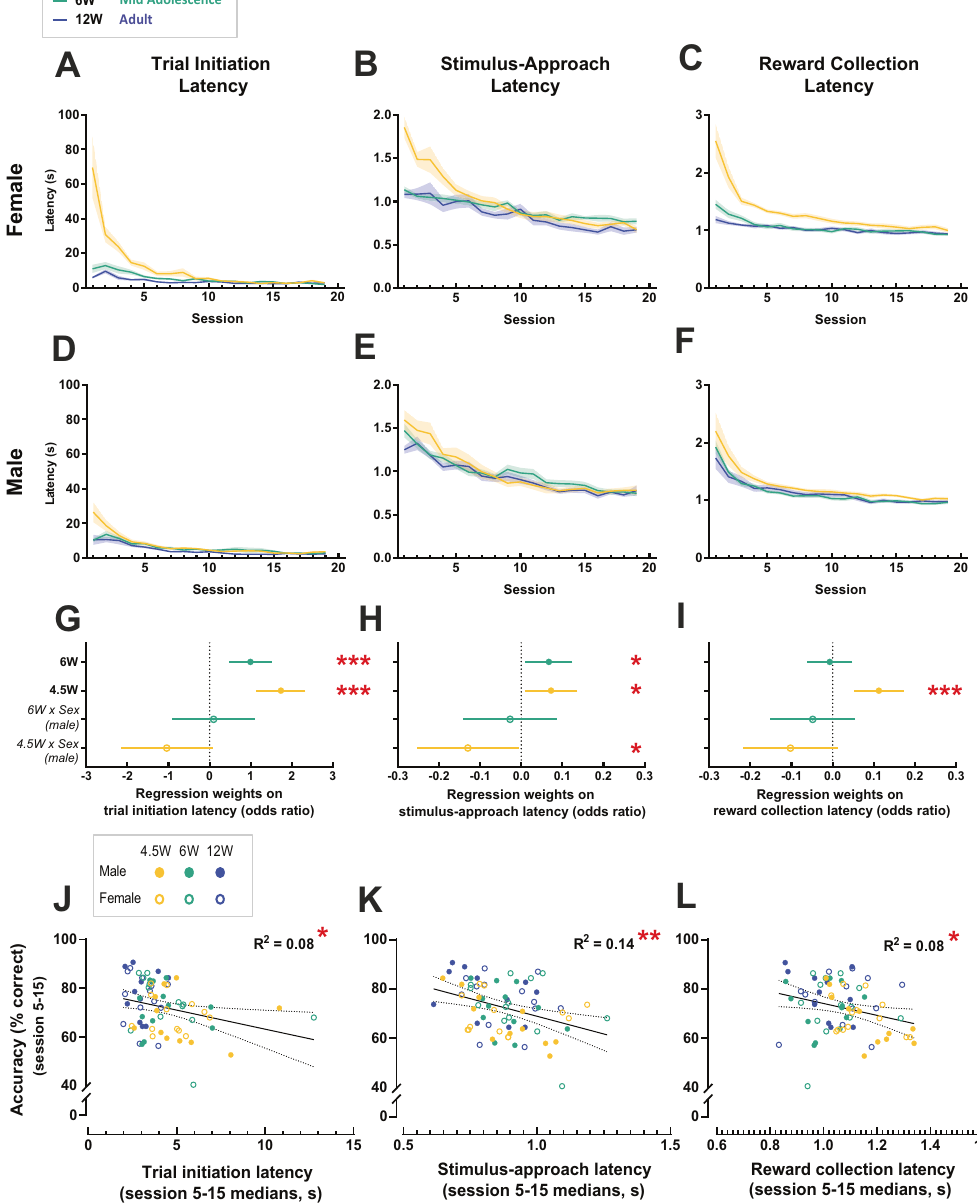
Fig. 6 Interaction between motivation and learning across developmental ages. To measure the motivation of mice to perform the two- object sPAL, we measured latencies to initiate the commencement of a trial (trial initiation latency) ( A , D , G ), approach the touchscreen (stimulus-approach latency) ( B , E , H ), and collect rewards after a correct response (reward collection latency) ( C , F , I ) in male and female mice across the three developmental age groups. A – F Data represent mean ± SEM. G – I Median regression; Point estimates are shown with 95% CI (4.5 W: n = 13 male, n = 11 female; 6 W: n = 13 male, n = 12 female; 12 W: n = 13 male, n = 12 female, see Supplemental Table S2 for complete statistics). Regression weights of key variables and their interaction effects on latencies were estimated and expressed as odds ratios. An odds ratio >0 indicates an increased latency difference to perform that action, and <0 indicating a decreased latency difference. For regression analyses, 12 W adult mice were used as the reference age, thus effect of age (e.g. 6, 4.5 W) re fl ects the performance of 6 or 4.5 W mice relative to adult mice. Similarly, female mice were used as the reference sex, thus the effect of sex (e.g. male) re fl ects the performance of male mice relative to female mice. Relative to 12 W adult mice, both 6 and 4.5 W mice took signi fi cantly longer to G initiate trials and H approach the stimulus on the touchscreen, while only 4.5 W mice took longer to collect rewards ( I ). Interaction effects indicated that at 6 W, both male and female mice displayed similar latencies to initiate trials, approach the stimulus and collect rewards ( 6 W × Sex (male )). However, at 4.5 W, male mice tended to be faster than females at all three responses ( 4.5 W × Sex (male )) ( G , H , I ) with stimulus-approach latency being signi fi cantly different ( H ). These data indicate the tendency for early-adolescent mice in comparison to mid-adolescent and adults to have longer reaction times to perform these actions appears to be more pronounced in early adolescent female mice over early adolescent male mice. * P < 0.05, *** P < 0.001. J – L Linear regression between the average % accuracy pooled from mice between the steepest learning (sessions 5 – 15), and the average values of initiation latency, stimulus-approach latency and reward collection latency showed a signi fi cant negative correlation between the response accuracy and all three latencies. See Supplemental Table S2 for complete statistics. * P < 0.05, ** P < 0.01 (4.5 W: n = 13 male, n = 11 female; 6 W: n = 13 male, n = 12 female; 12 W: n = 13 male, n = 12